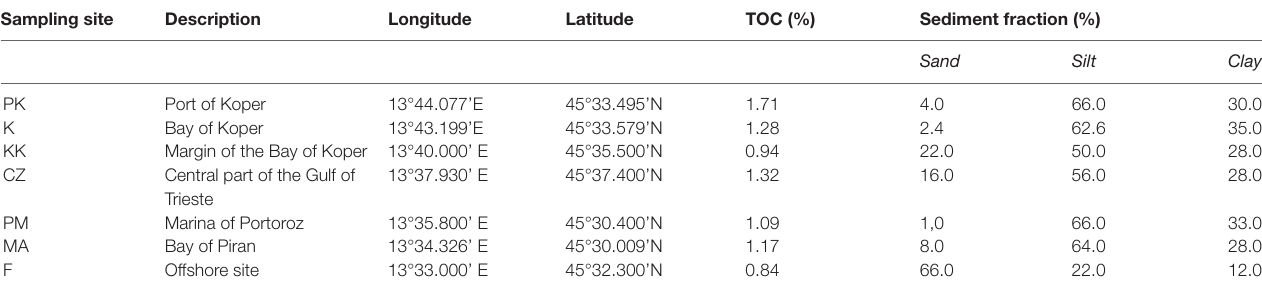
TABLE 1 | Description of sampling sites; sediment fraction from Ogorelec et al. (1991), TOC from Bajt